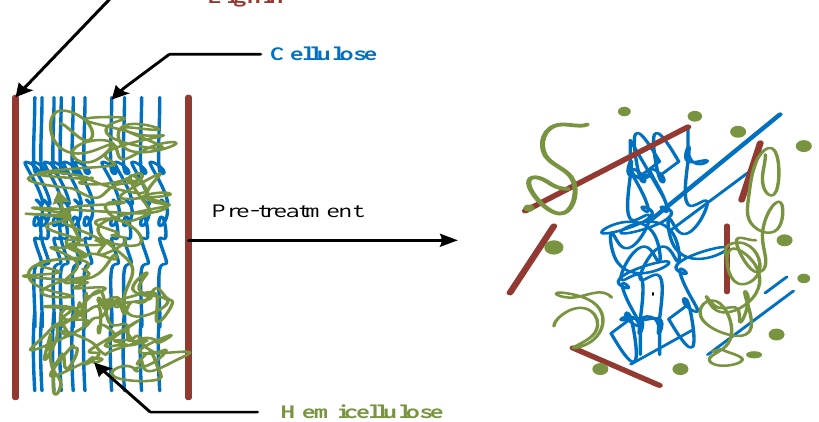
Figure 4. Modification of the lignocellulosic structure during pretreatment (adapted from [36]).